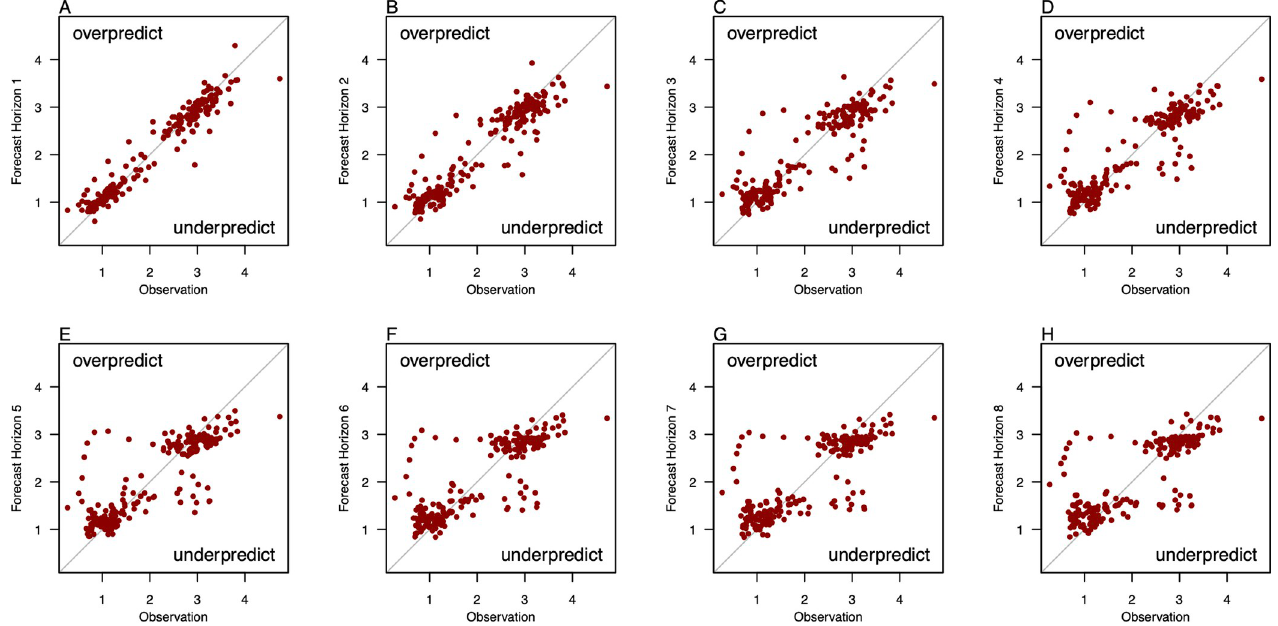
Fig 4. Visualization of forecasts generated using forecast combinations against observations in the full forecasting dataset with the line of equality plotted to ascertain forecasts of over or underprediction. Different panels represent the forecasts versus observations for the forecast horizon of 1–8 steps ahead].